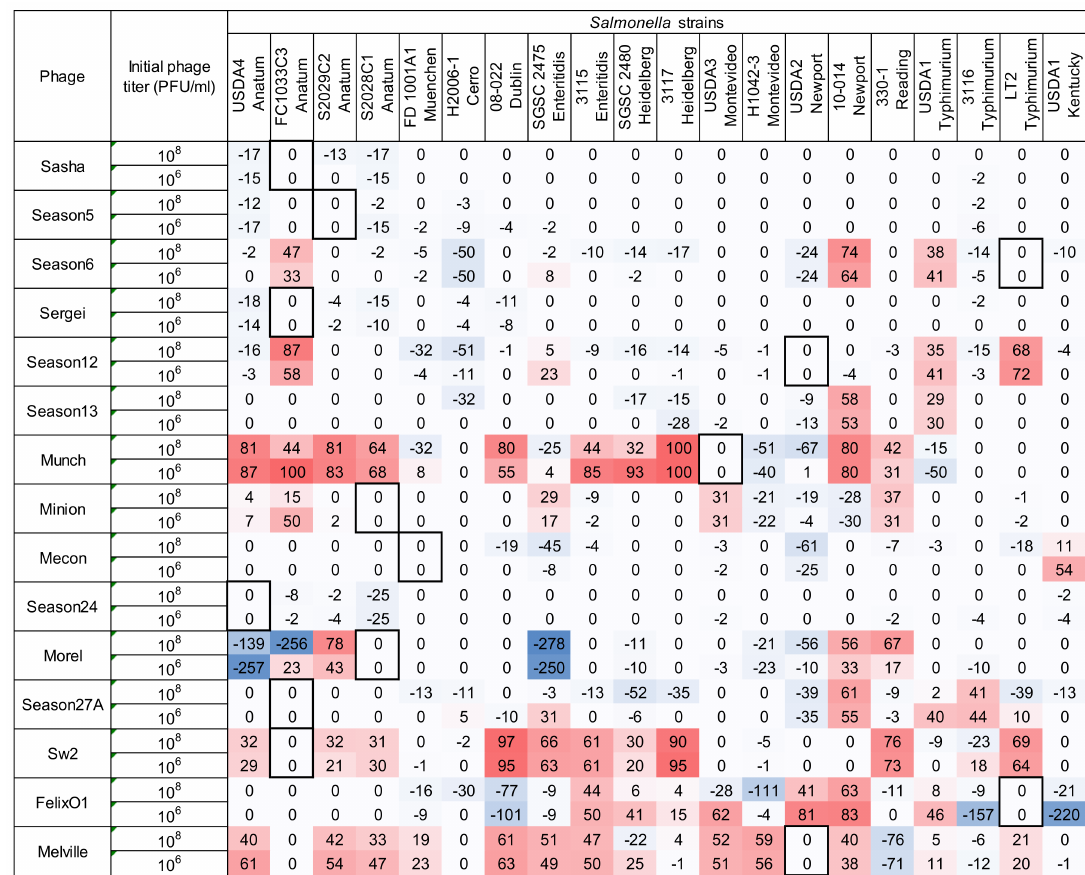
Figure 5. Agreement levels between two host range methods. Equation (3) was used to determine agreement levels between two host range methods. One spot assay score representing one bacteria-phage combination (see Figure 1) was compared to two liquid assay scores at two different phage concentrations (see Figure 3) to determine if one phage concentration in the liquid assay yielded a difference in agreement levels. Values closer to zero indicate greater agreement between the two methods and values closer to 100 indicate disagreement. Negative values indicate greater bacterial sensitivity to phages observed in the liquid assay and positive values indicate greater sensitivity observed in the spot assay. Color intensity indicates greater divergence from zero in either direction, with blue shades indicating negative values and red shades indicating positive values. Boxed cells indicate the initial isolation and propagation host of the